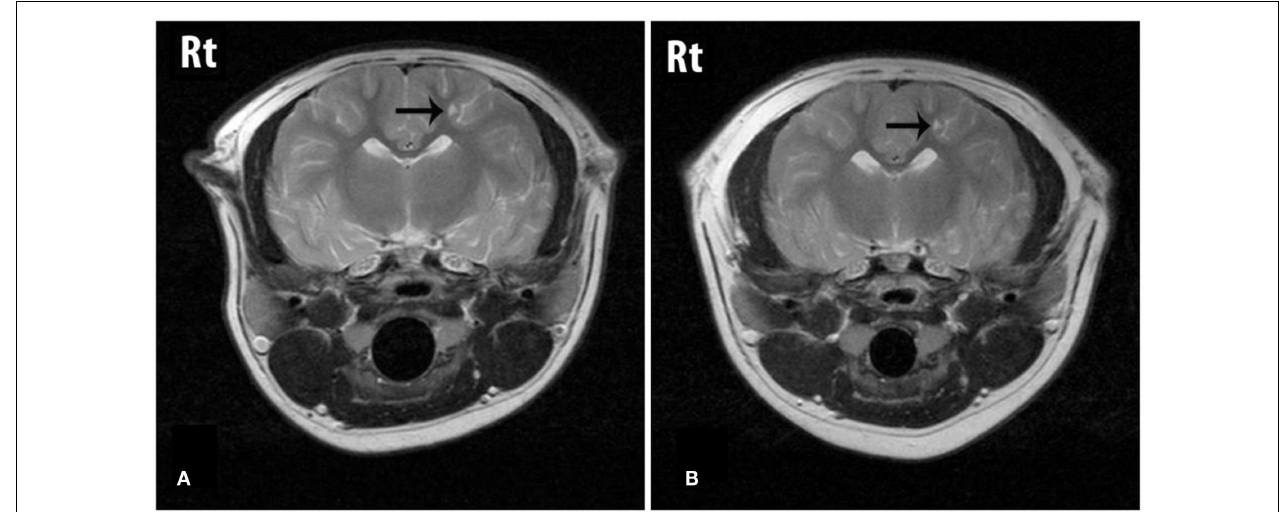
FIGURE 1 |T2W transverse images through the cerebrum showing a lesion (arrow) that is fluid filled on both the initial (A) and the follow-up (B) studies. The lesion is considered static between dates.